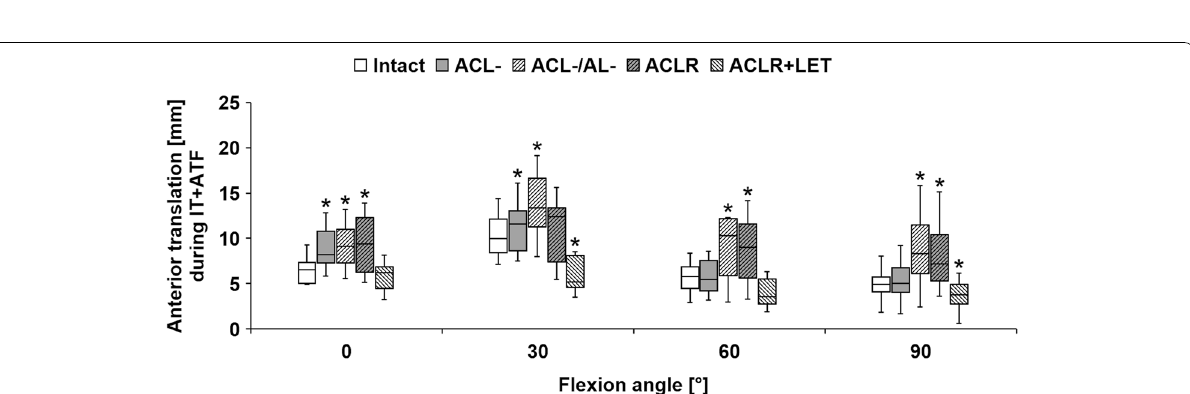
Fig. 9 Anterior translation during the application of combined internal tibial torque and anterior tibial translation force (IT between the intact state, state with resected anterior cruciate ligament (ACL-), state with resected ACL combined with anterolateral rotatory instability (ACL-/AL-), state with ACL reconstruction (ACLR), and state with ACLR and addition of a lateral extra-articular tenodesis (ACLR different angles of knee flexion. Significant differences from the intact state are marked with an asterisk (*) for each flexion